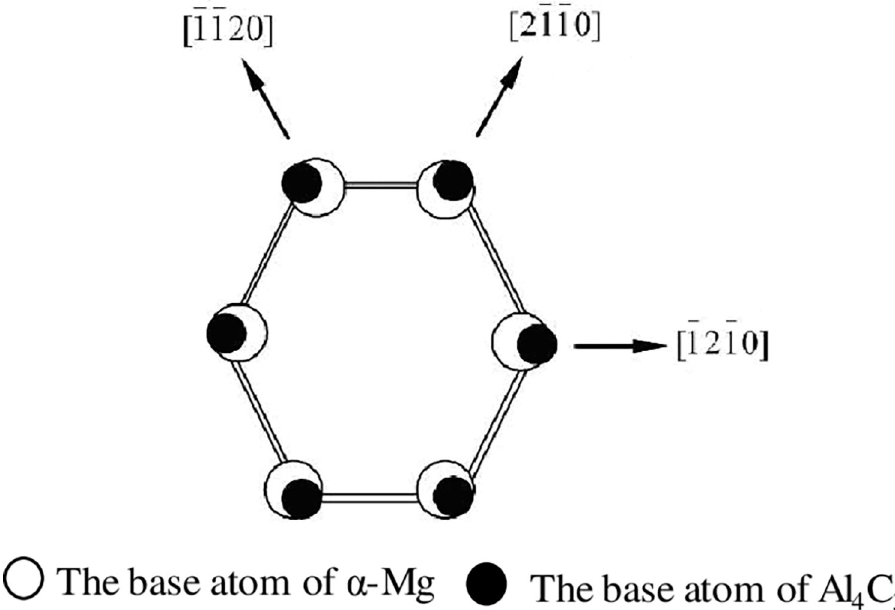
Fig 10. Scheme of the relationship of nucleation sites between α -Mg and Al 4 C 3 .